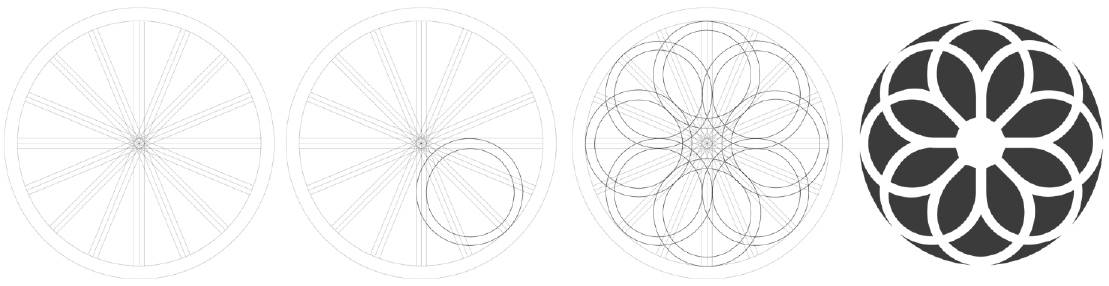
Figure 17. Past Experience.